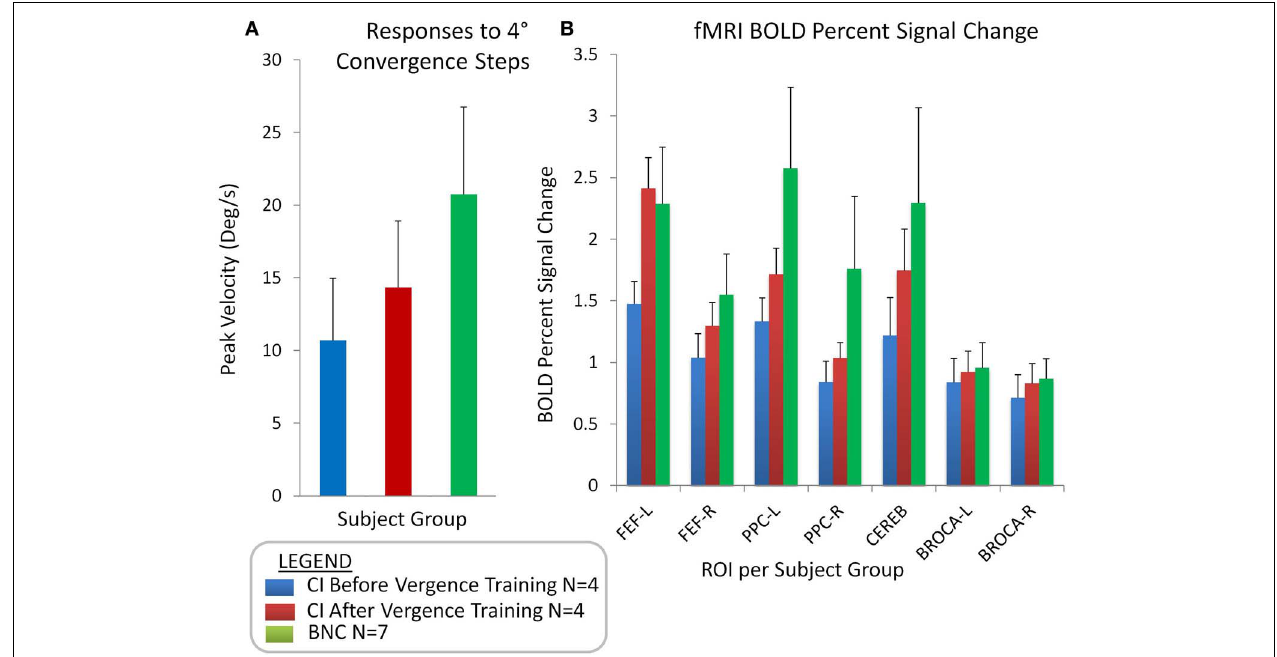
FIGURE 5 | Group-level analyses showing the average with one standard deviation of convergence peak velocities ( ◦ /s) evoked from 4 ◦ symmetrical convergence step stimuli (A) for CI subjects before vergence training (blue bar), CI subjects after vergence